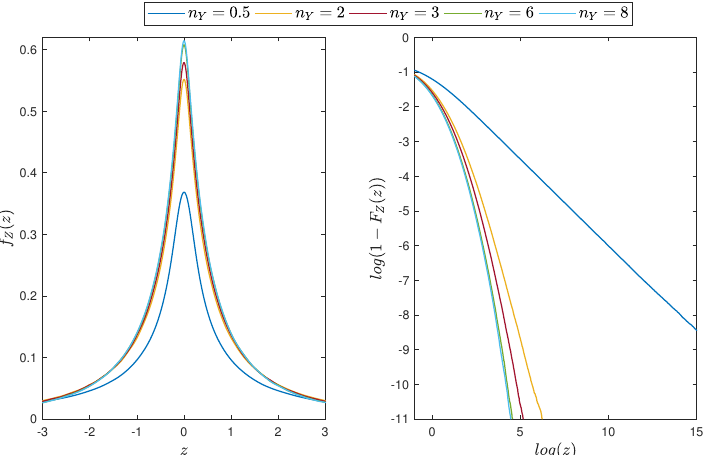
Figure 9. Distribution of the product of two independent random variables from the log-normal and Student’s t distribution with µ X = 0 and σ X = 1 and different values of n Y parameter. ( Left panel ): the PDF of the random variable Z ; ( Right panel ): the distribution tail for the random variable Z (in log-log scale).